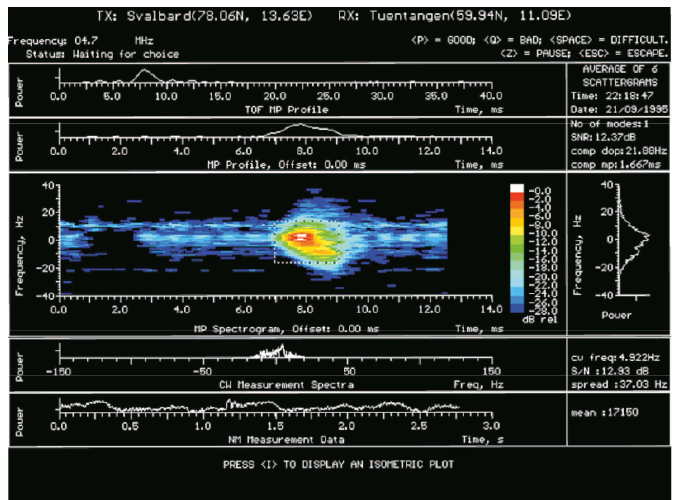
Figure 6. Example DAMSON output, from Reference